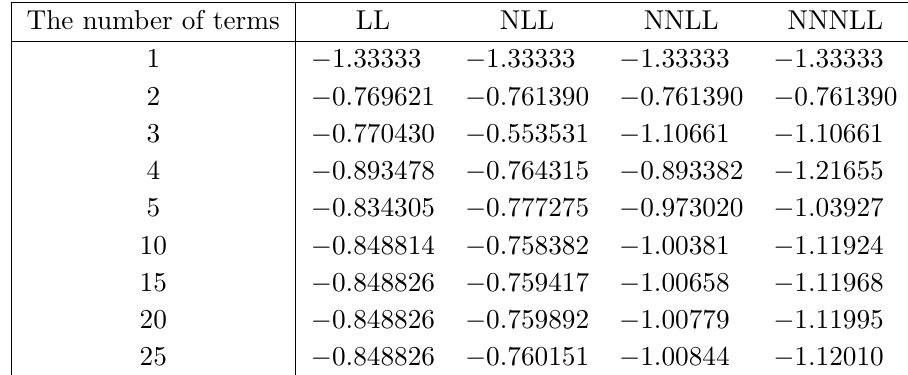
Table 1 . Estimates of normalization constant N RG-improved